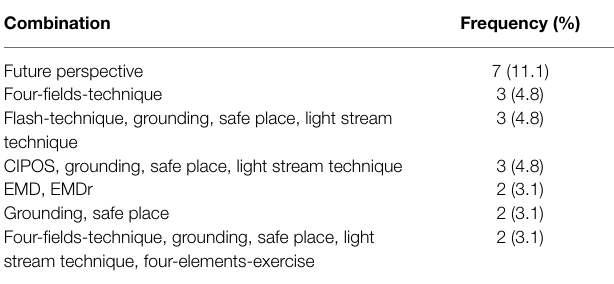
TABLE 1 | Most frequent combinations of the standard EMDR protocol in eEMDR